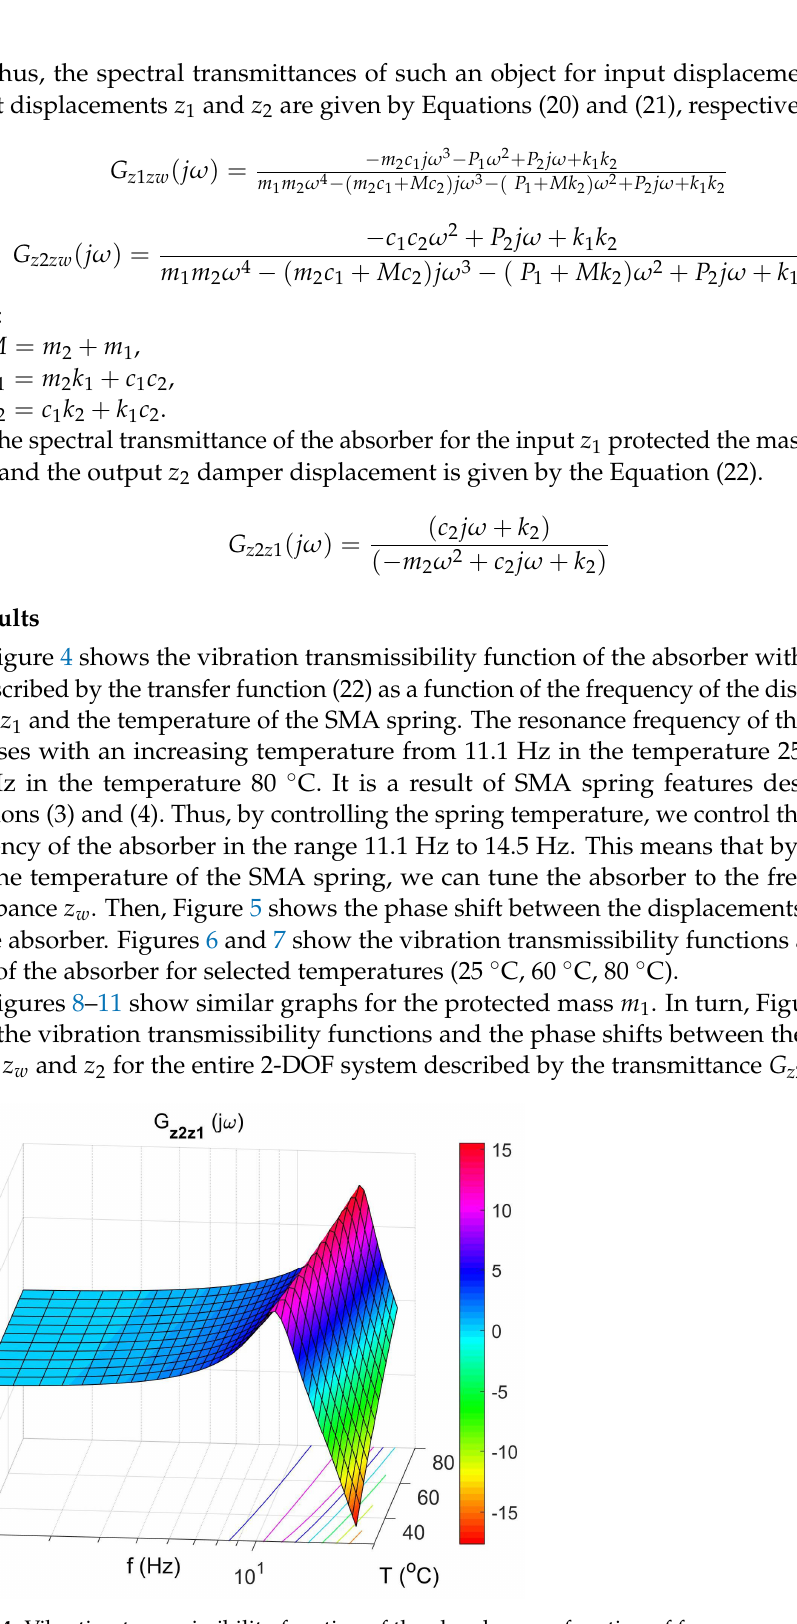
Figure 4. Vibration transmissibility function of the absorber as a function of frequency and tempera- ture, the transfer function G z 2 z 1